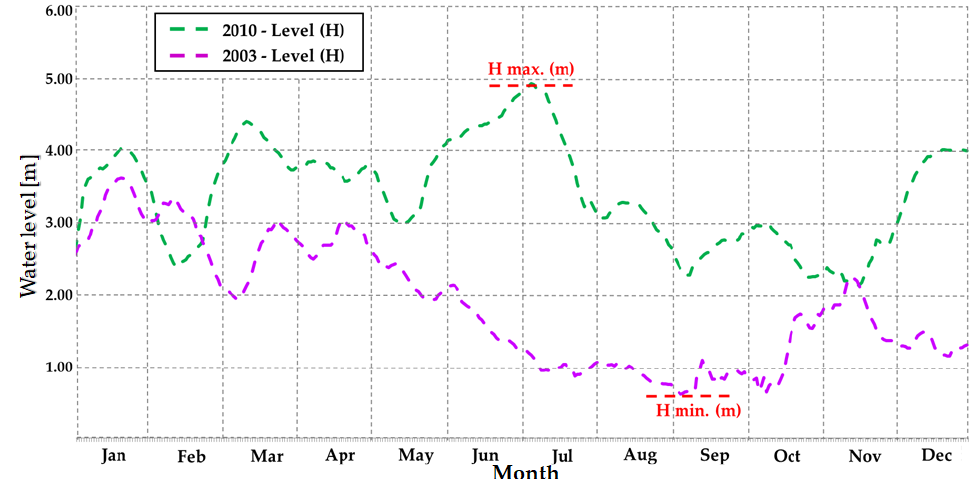
Figure 3. Monthly evolution of the Danube water levels at the Tulcea-port hydrometric station during 2003 and 2010.